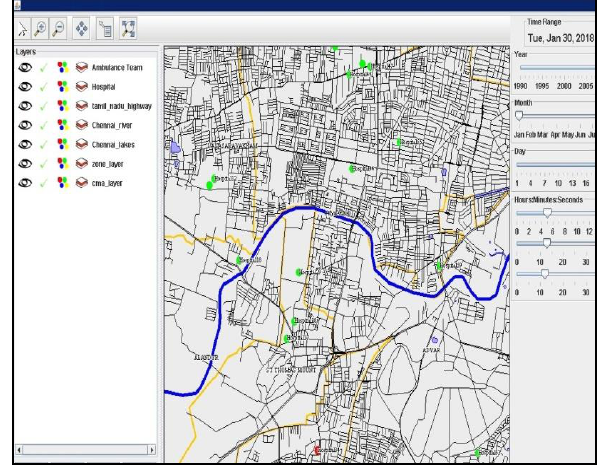
Figure 6 . Geo-visualization for IoT flood sensor network integrated with Interdependent HCI SCPN Simulation